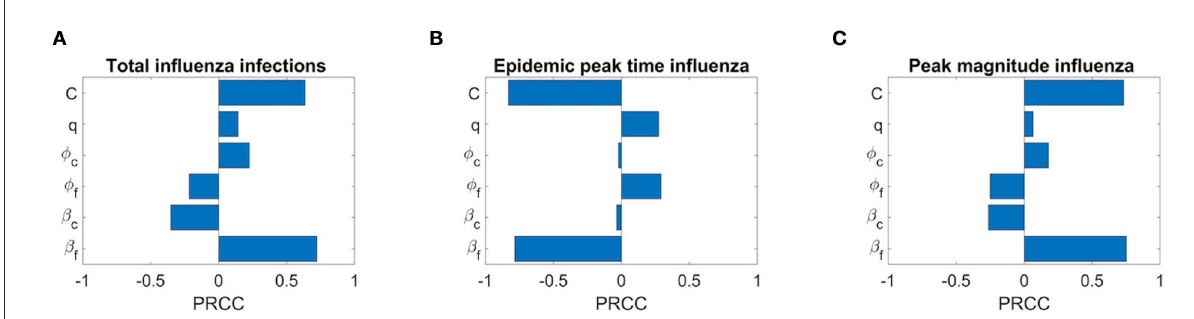
FIGURE13 Sensitivity analysis of three epidemic outcomes of influenza. (A–C) Total number of influenza infections, epidemic peak time of influenza, and peak magnitude of influenza,